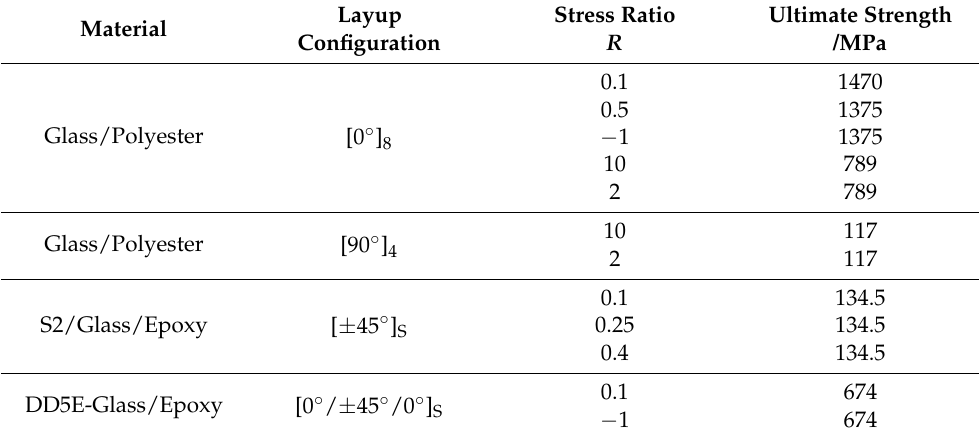
Table 1. Composite layup configuration and ultimate strength from Ref.